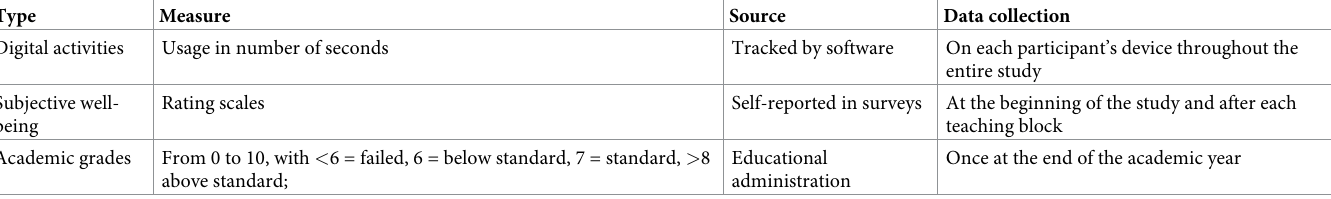
Table 1. Overview of data